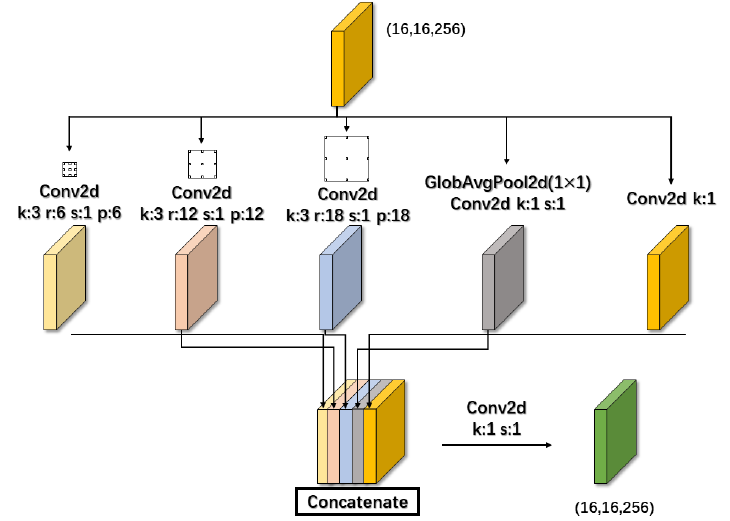
Figure 4. The structure of the atrous spatial pyramid pooling